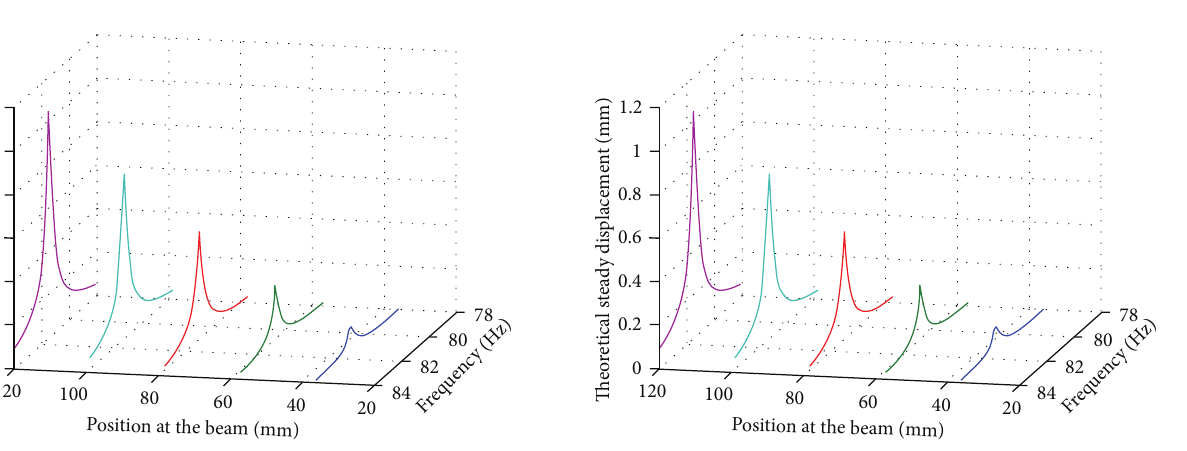
Figure 15: Theoretical steady-displacement responses versus posi- tions and frequencies with mode 𝑈 (3) 1 (𝑥)